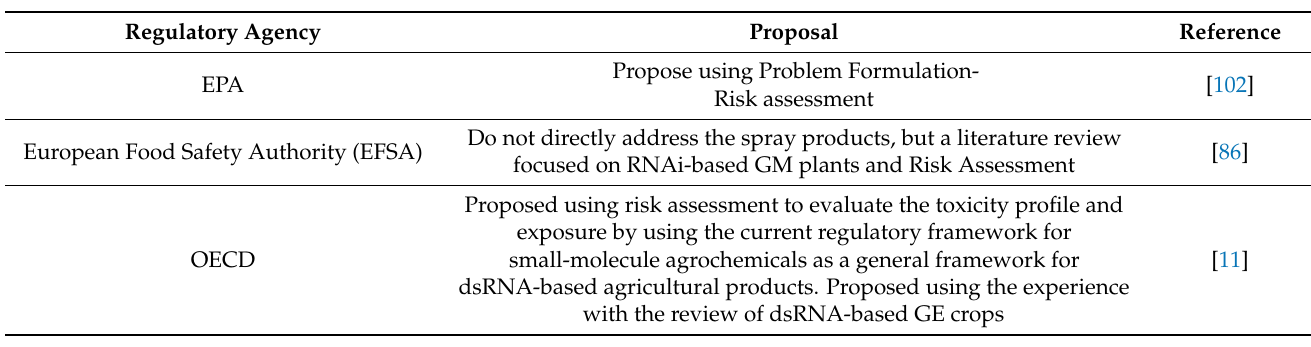
Table 3. Regulatory